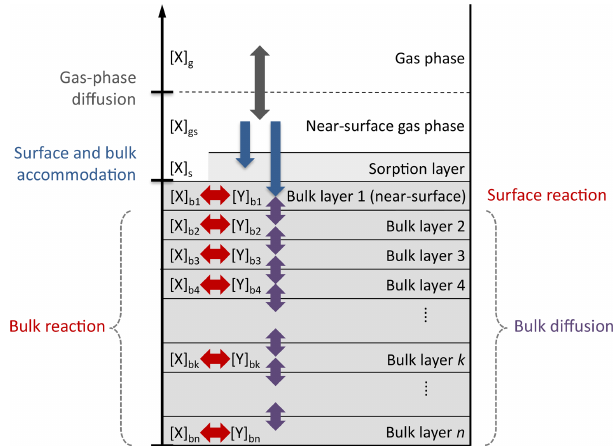
Figure B1. Compartments and processes of the kinetic multi-layer model of aerosol surface and bulk chemistry